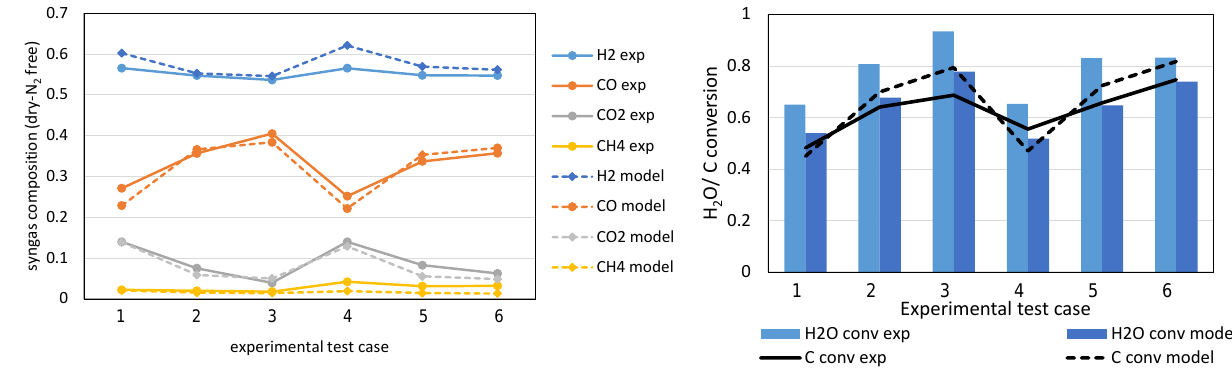
Figure 8. HTW gasifier model validation based on data from [19].